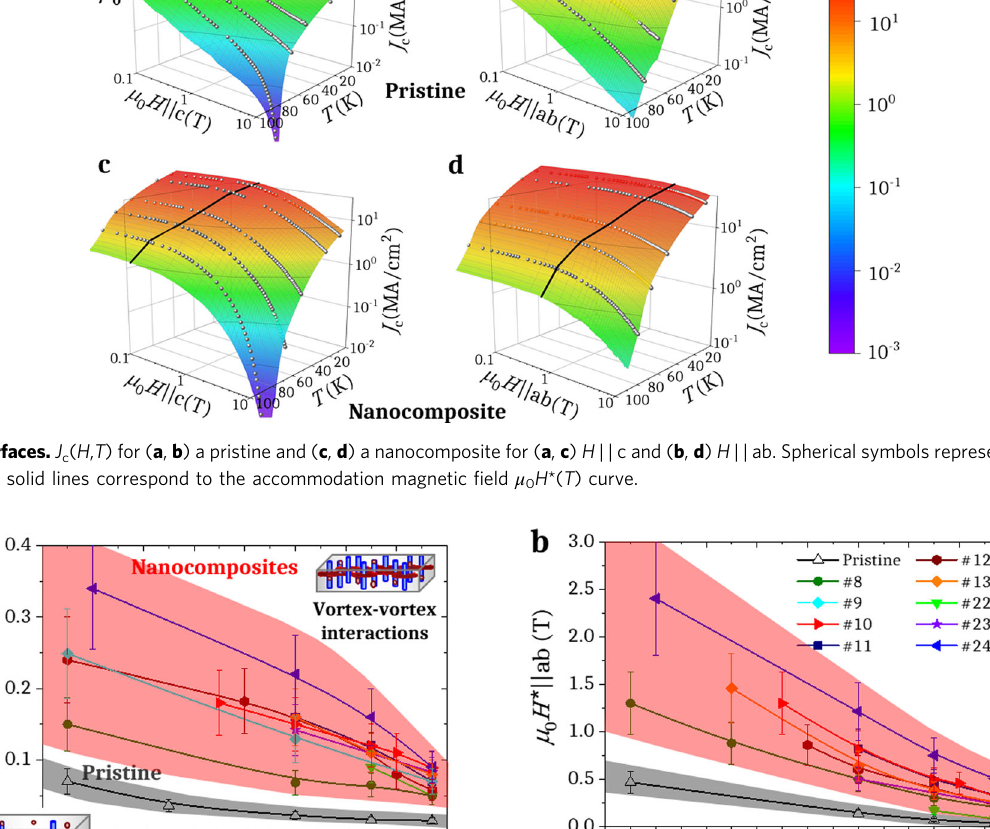
Fig. 2 Pinning regimes in the H – T diagram. Temperature dependence of μ 0 H * for ( a ) H | | c and ( b ) H | | ab for pristine and ss-nanocomposites (sample details are indicated in supplementary table S1). μ 0 H *( T ) separates single vortex pinning from vortex-vortex interactions regimes in the H – T diagram. Error bars are determined by the standard deviation of μ 0 H * for iterative